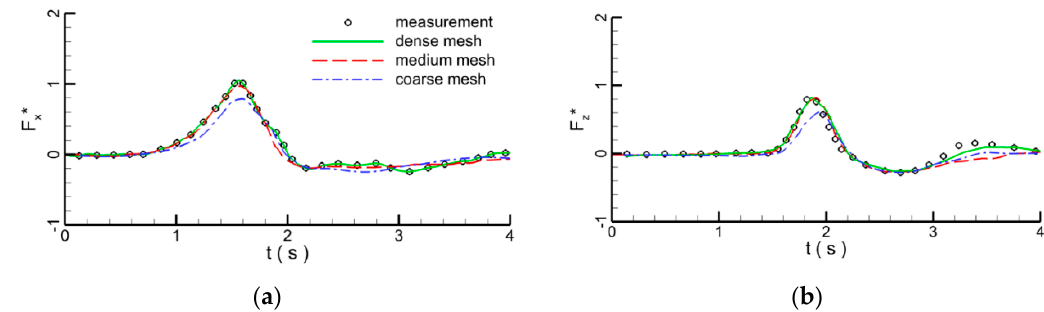
Figure 7. Force comparison between measurement and simulation in run 2; ( a ) horizontal force F x *; ( b ) vertical force F z *.